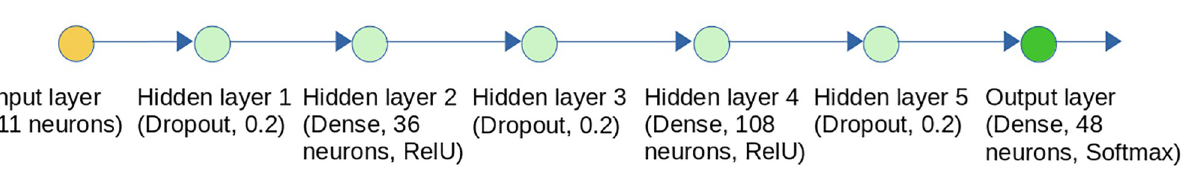
Fig 6. A simplified graph for the age prediction neural network.